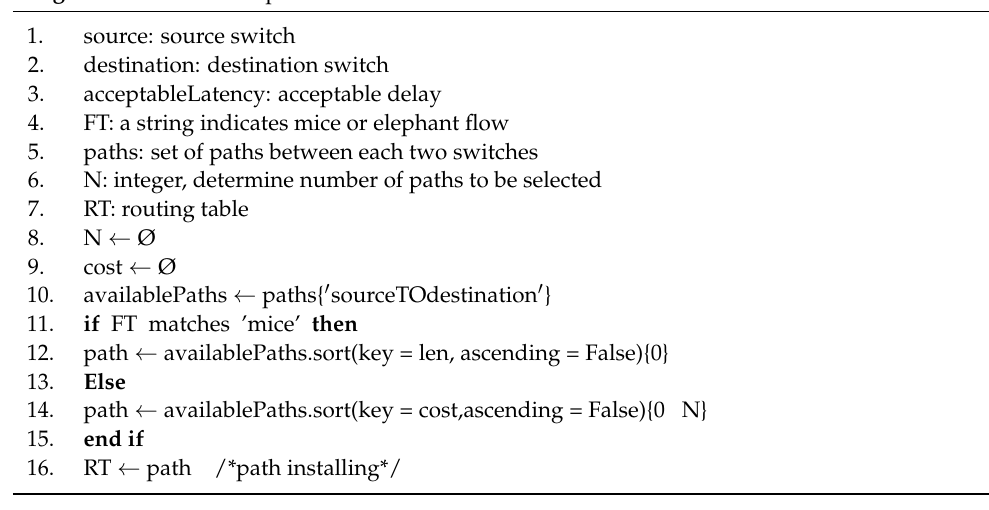
Algorithm 5 Select best